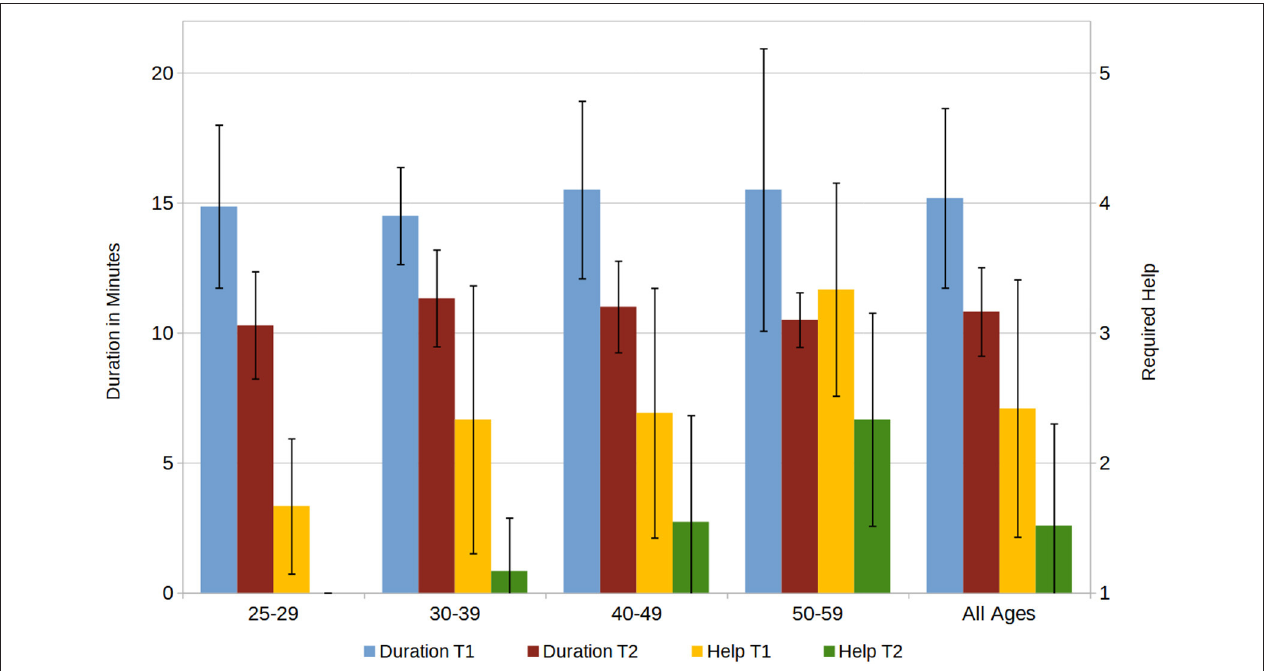
FIGURE 4 | Required duration for completion of the first and second task (T1, T2) in minutes and the required assistance, rated on a 1–5 Scale (1 = “no help,” 5 = “a lot of